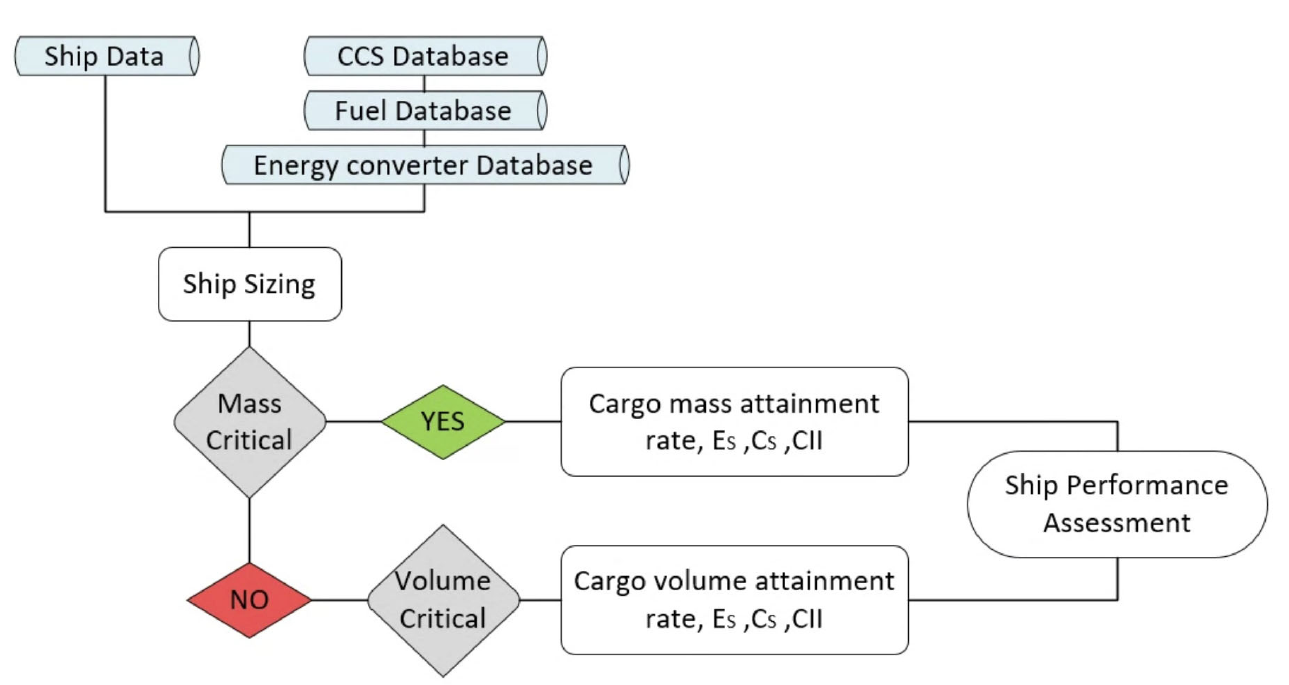
Figure 1. Research process flow diagram. Table 1. Data of the reference ship (HFO ‐ fuelled containership).